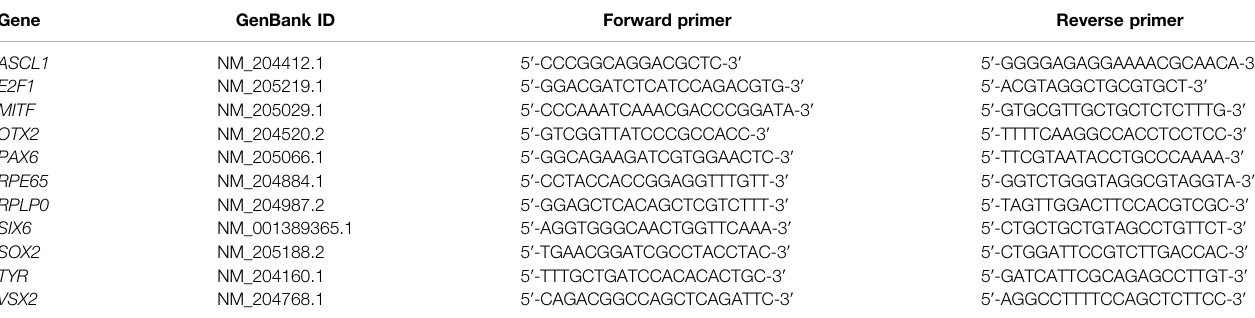
TABLE 1 | List of primers used in